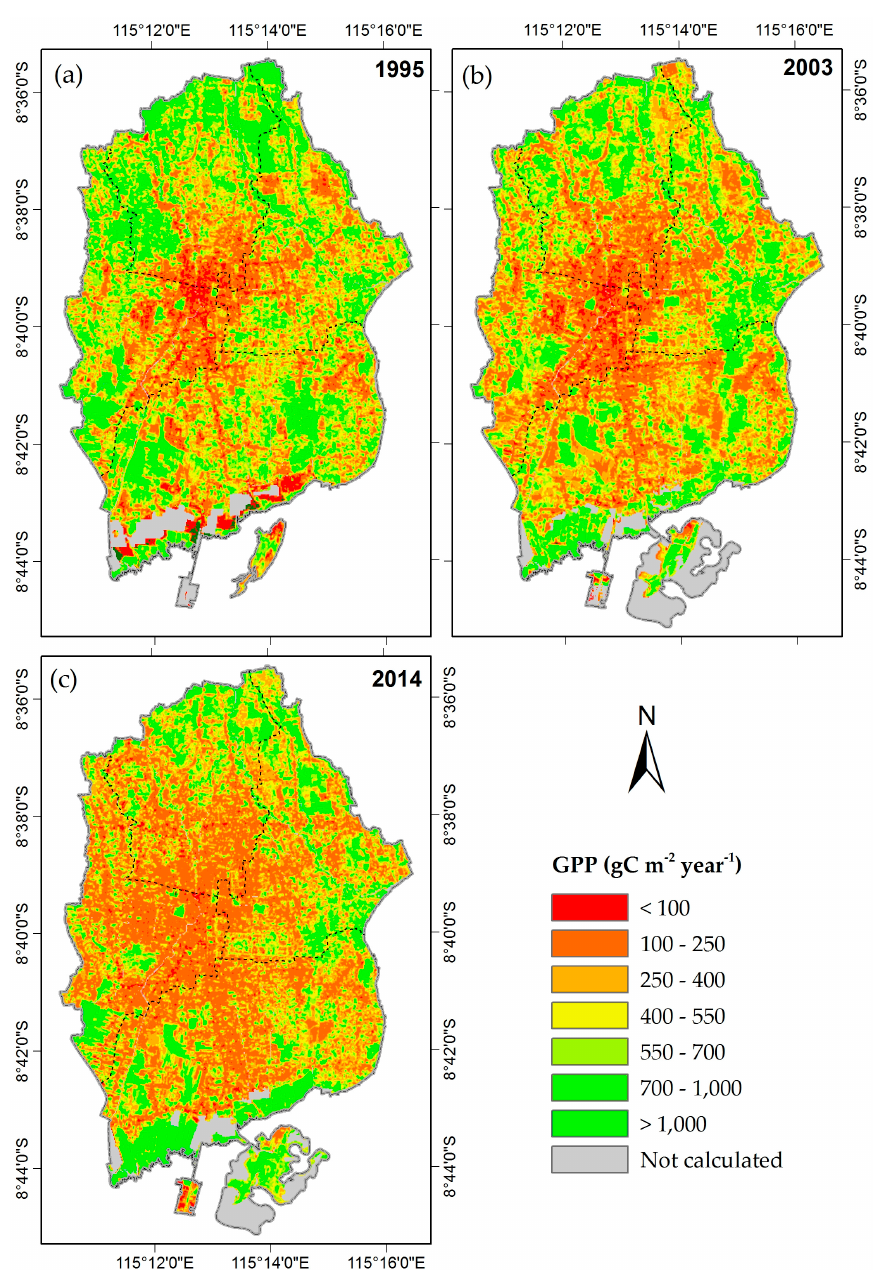
Figure 4. Annual gross primary production (GPP) distribution in Denpasar from Landsat satellite data analysis. The grey colour indicates that the area is not counted due to land use types such as water and others. ( a ) 1995; ( b ) 2003; and ( c ) 2014.